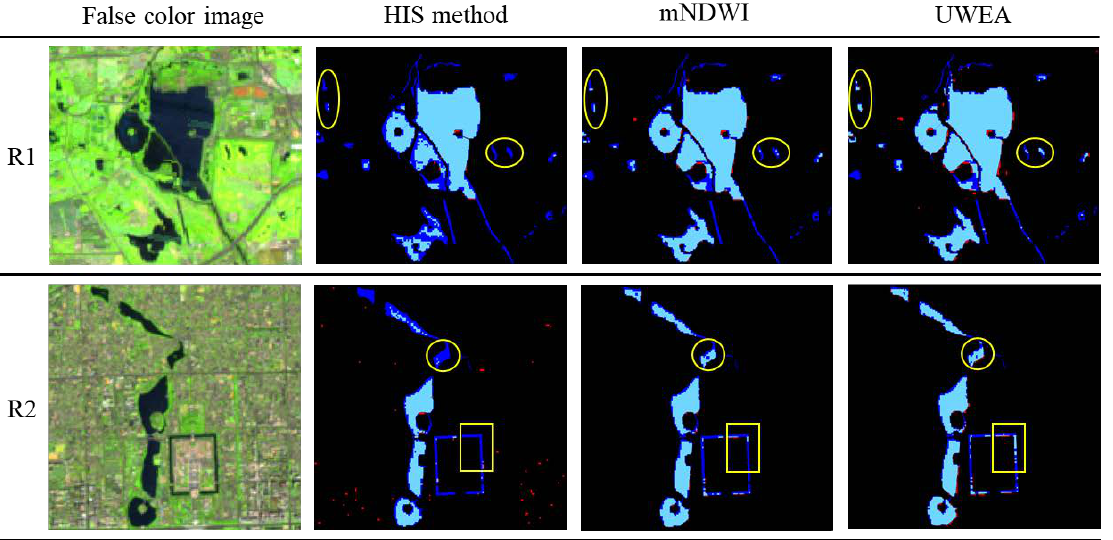
Figure 7. The water maps extracted via the HIS method, mNDWI, and UWEA for Beijing. The figures in light blue, dark blue, and red indicate accurately detected water bodies, undetected water bodies (omission area), and the inaccurate extraction of water bodies (commission area), respectively. The yellow circles and rectangles highlight the differences in extracted small water bodies using different